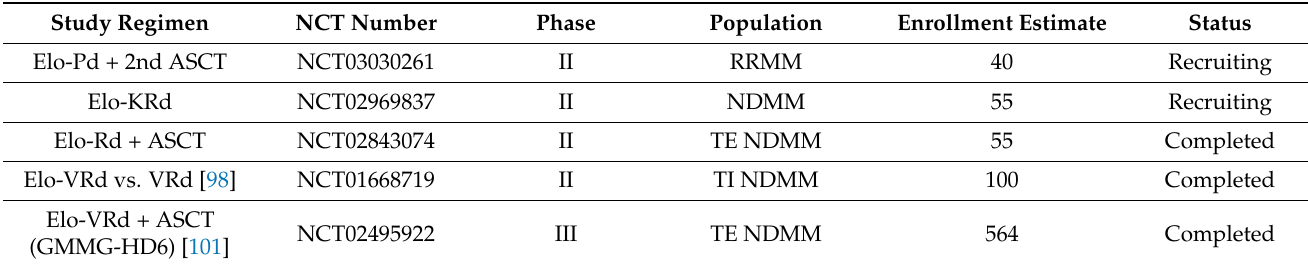
Table 6. Selected ongoing trials with regimens containing elotuzumab.